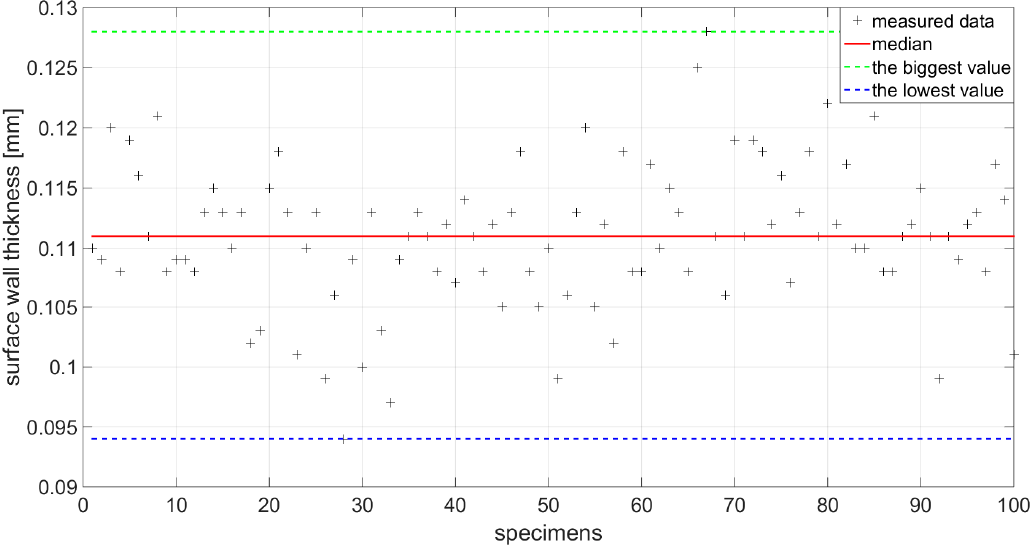
Figure 10. Measured values of wall thickness.